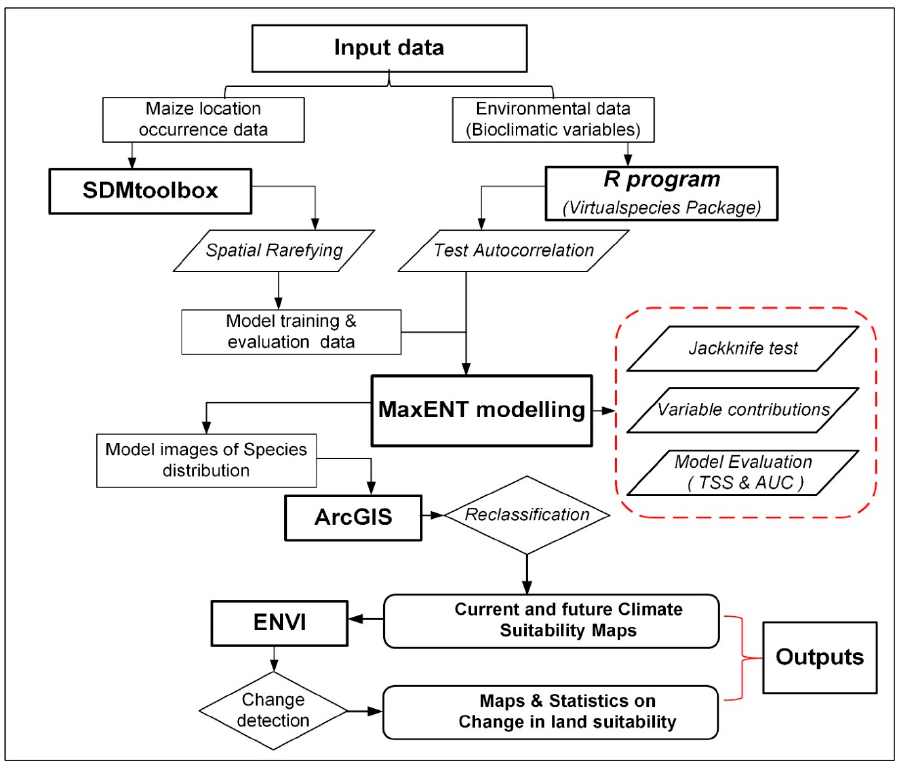
Figure 3. Flowchart summarizing the methodology used in this study .